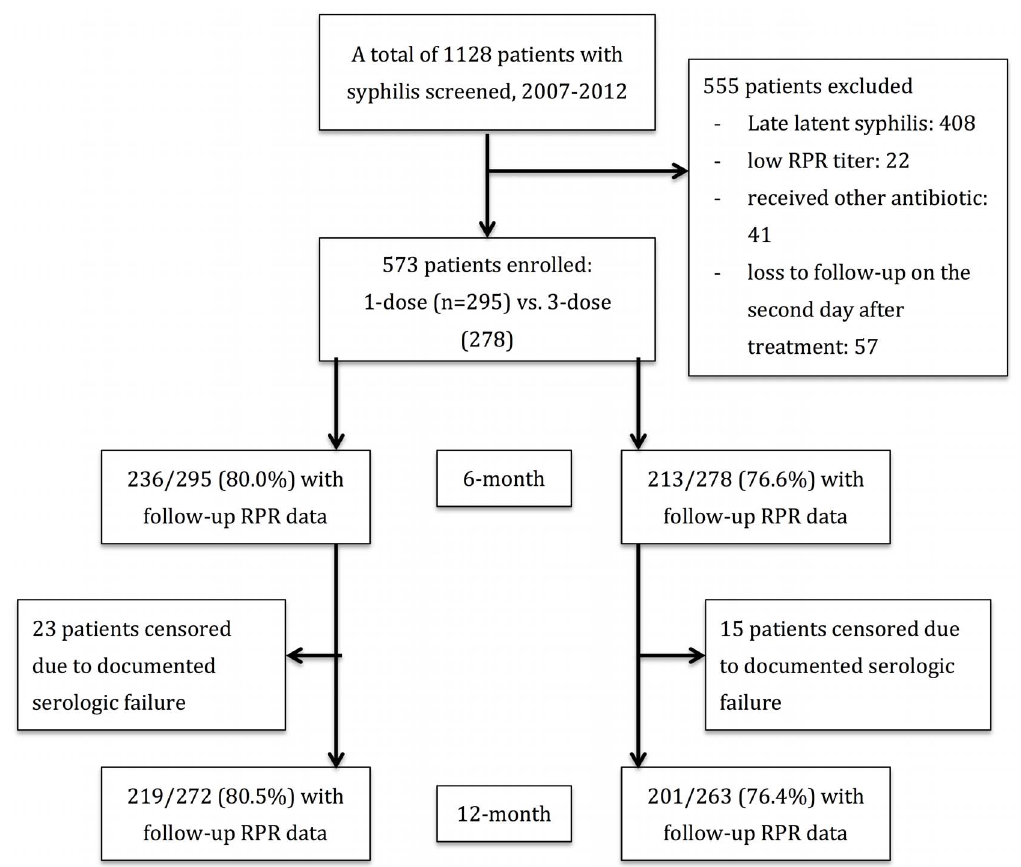
Figure 1. Study flow showing patient recruitment and patients with available rapid plasma reagin (RPR) data during the 6 and 12 months of follow-up.